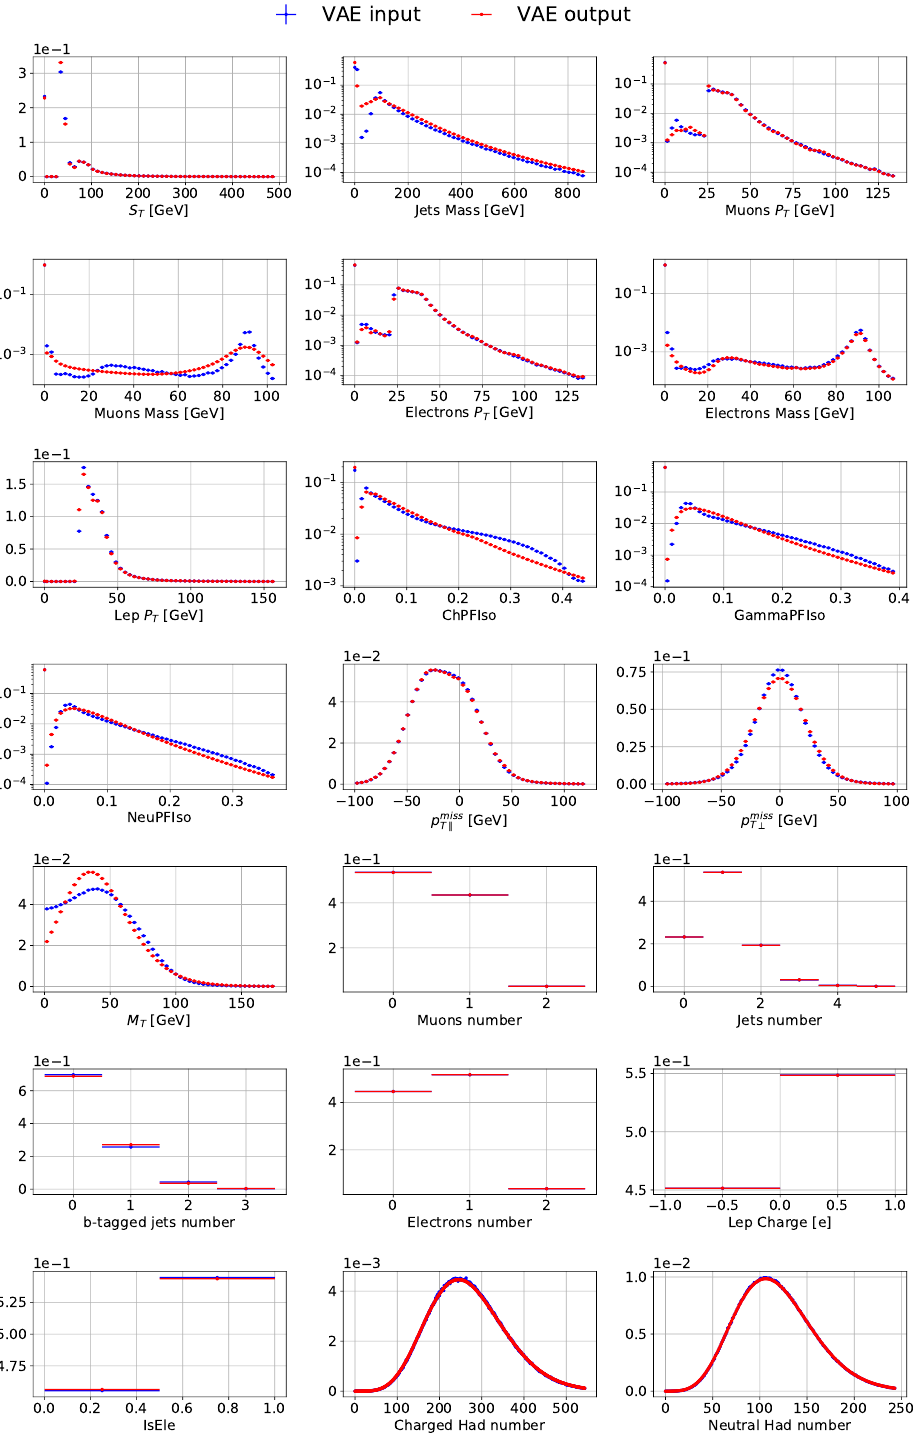
Figure 5 . Comparison of input (blue) and output (red) probability distributions for the HLF quantities in the validation sample. The input distributions are normalized to unity. The output distributions are obtained summing over the predicted pdf of each event, normalized to the inverse of the total number of events (so that the total sum is normalized to unity).